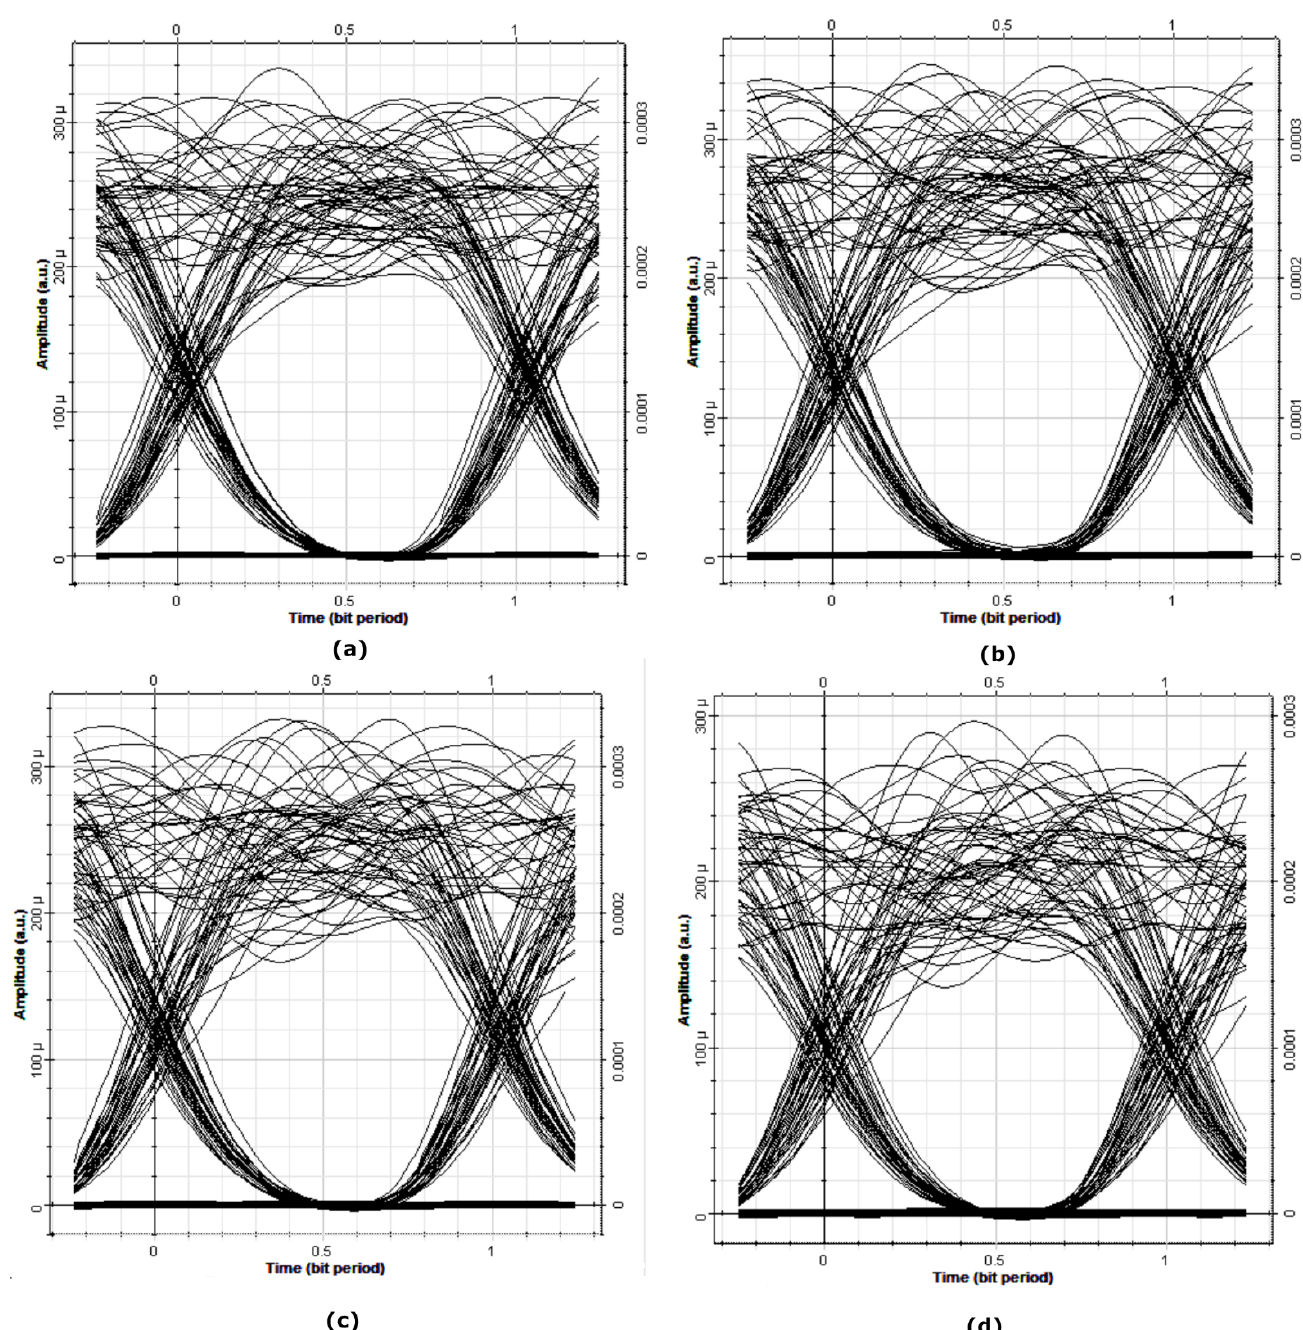
Figure 8. Eye diagram indicating performance of six users with different data rates: ( a ) 1 Gbps: Max. Q = 8.4, Min. BER = 4.6 × 10 − 14 ( b ) 1.5 Gbps: Max. Q = 7.4, Min. BER = 3.9 × 10 − 11 ( c ) 2 Gbps: Max. Q = 7.01, Min. BER = 6.59 × 10 − 10 ( d ) 2.5 Gbps: Max. Q = 6.42, Min. BER= 8.36 × 10 − 9 .